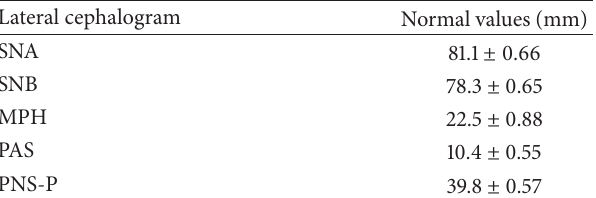
Table 1: Showing the normal values of the variables studied.